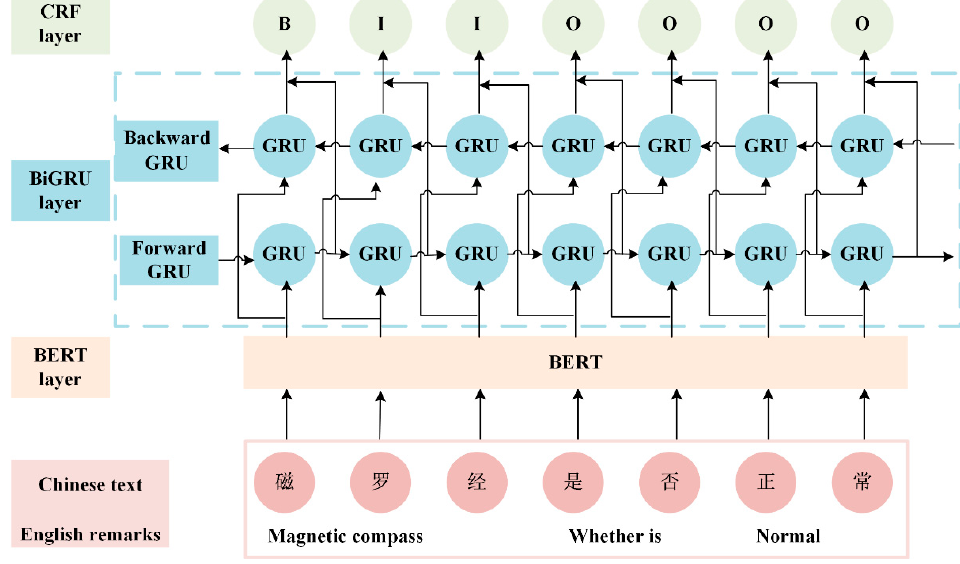
Figure 2. The BERT-BiGRU-CRF model structure [29]. The "Chinese text" part refers to the specific content of the obtained text data, which means “Whether magnetic compass is normal”.